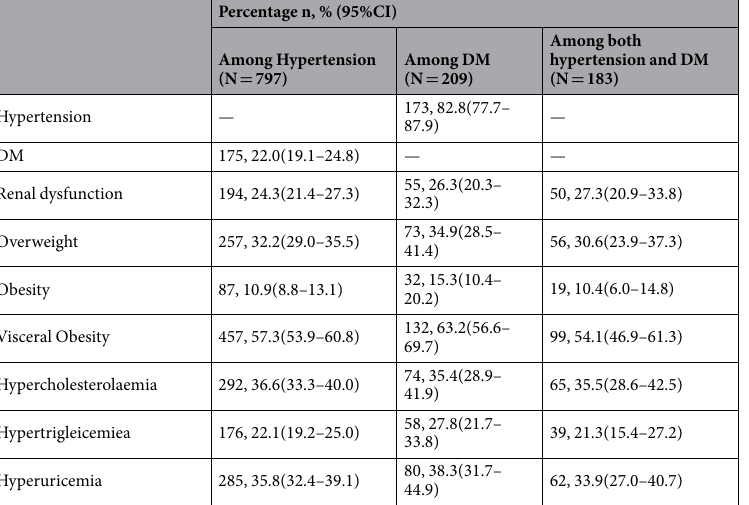
Table 3. Percentage of comorbid abnormalities. DM, diabetes mellitus. Data are presented as frequencies (percentages) for categorical variables. All p value > 0.05, comparison between groups hypertension and